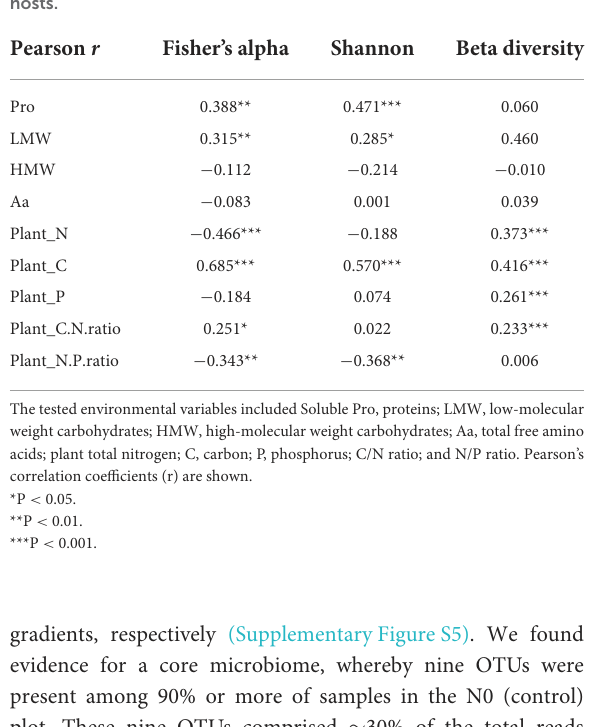
TABLE 3 Pearson’s product–moment correlations between environmental variables and alpha (Fisher and Shannon indices) and beta diversity (Bray–Curtis distances) of fungal endophytes in three